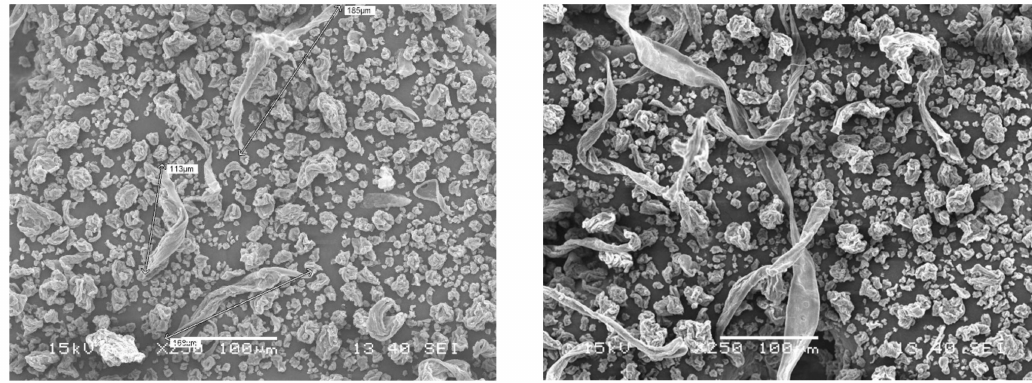
Figure 8. Representative Scanning Electron Microscopic (SEM) images of CNF used in this